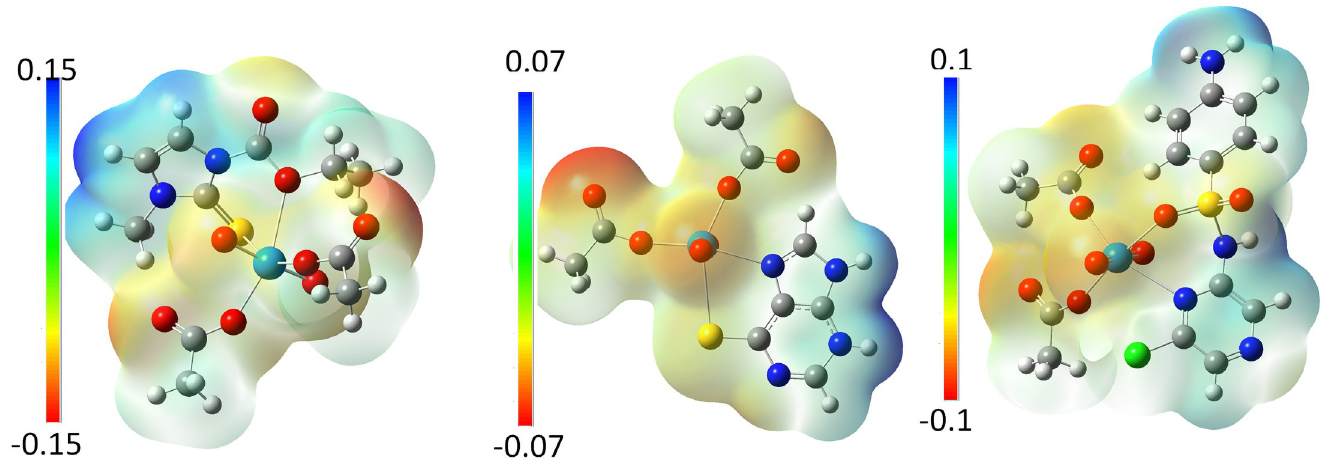
Fig 4. MEP maps of the UO 22+ -complexes calculated by the B3LYP/SDD method.